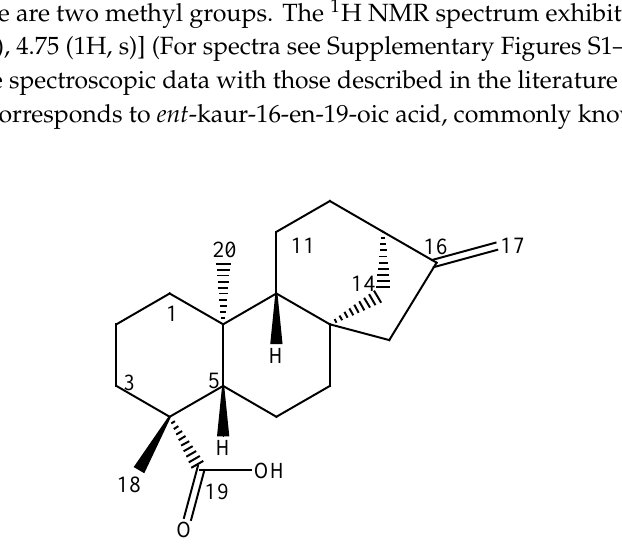
O Figure 6. Chemical structure of hinokinin ( 2 ) . Compound 3 was obtained as an oil. Analysis of the 1 H and 13 C NMR spectra, exhibited similarities with the spectroscopic signals found for compound 2 . However, we found the presence of a ketal group in δ 104.6, which was attributed to the reduction of the carbonyl group of the lactone in C-9. This